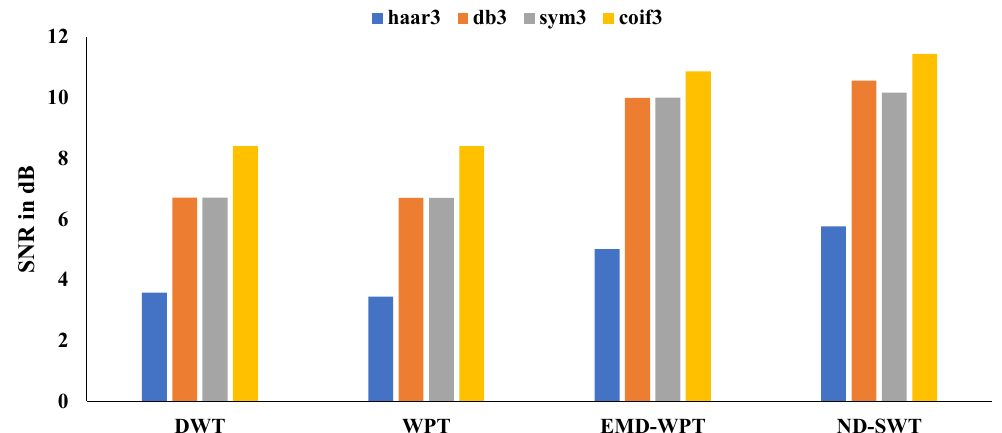
Figure 13. Comparison on SNRs of the simulation AE signal with respect to four methods using four different wavelets.